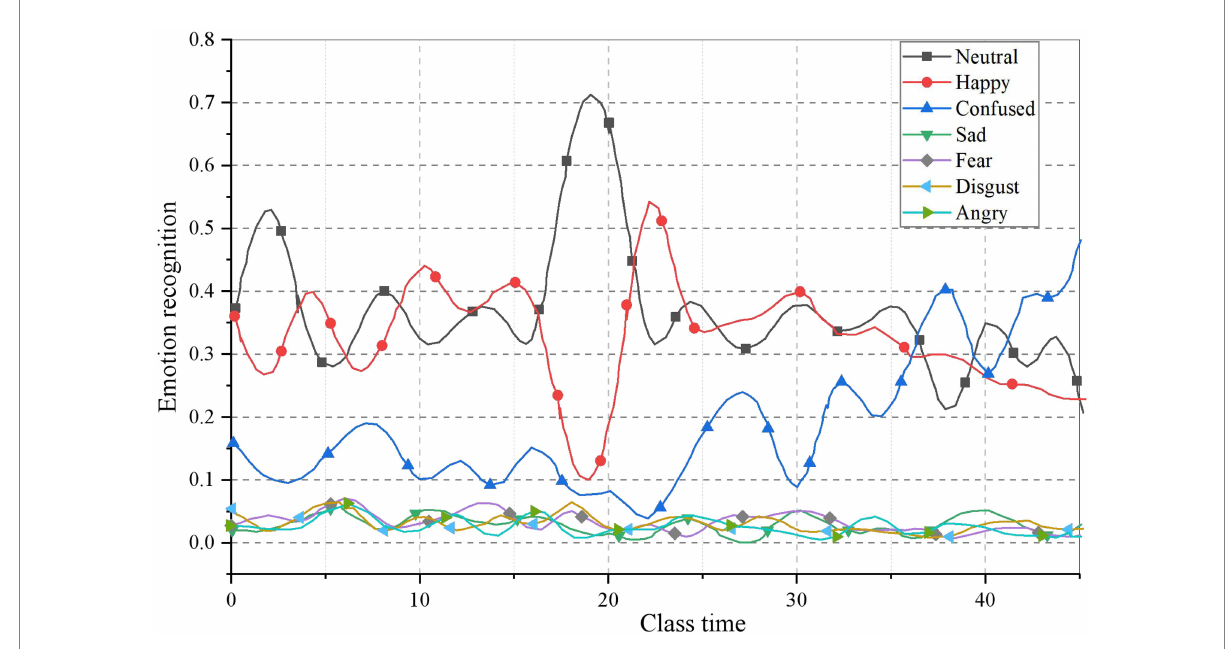
FIGURE 6 Results of students’ ER in the first